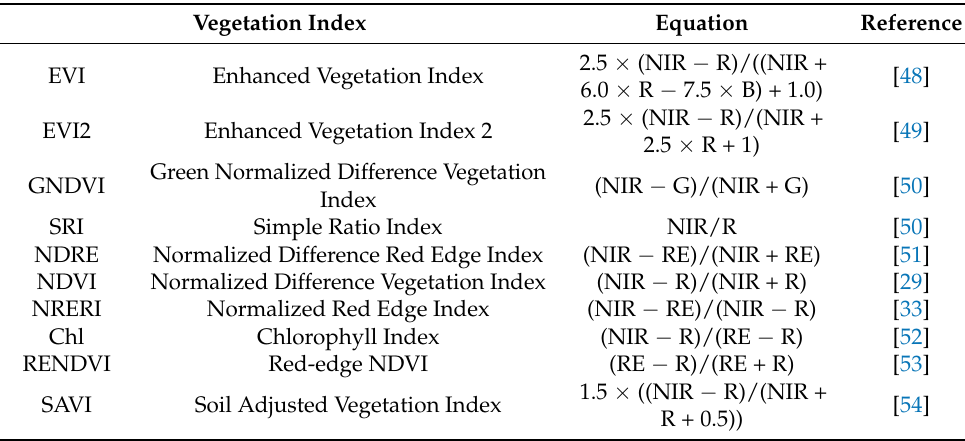
Table 1. Vegetation indices calculated from the UAV multispectral images. Vegetation Index Equation Reference EVI Enhanced Vegetation Index [48] EVI2 Enhanced Vegetation Index 2 Green Normalized Difference Vegetation GNDVI (NIR − G)/(NIR + G) Index SRI Simple Ratio Index NIR/R NDRE Normalized Difference Red Edge Index (NIR − RE)/(NIR + RE) NDVI Normalized Difference Vegetation Index NRERI Normalized Red Edge Index Chl Chlorophyll Index RENDVI Red-edge NDVI (RE − R)/(RE + R) 1.5 × ((NIR − R)/(NIR + SAVI Soil Adjusted Vegetation Index R +